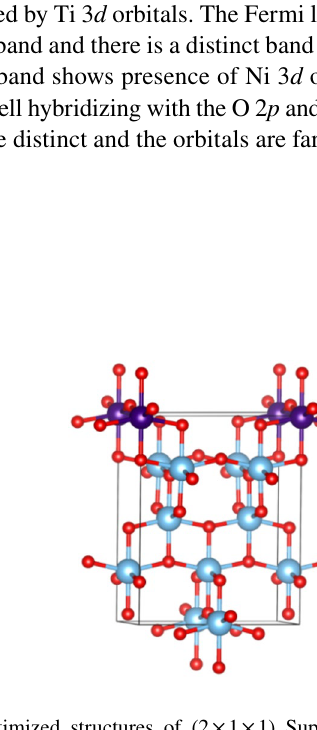
Fig. 2 Optimized structures of (2 × 1 × 1) Supercell of TiO with 4.17% Pd atom. Colour: Blue: Ti, Red: Oxygen, Violet: